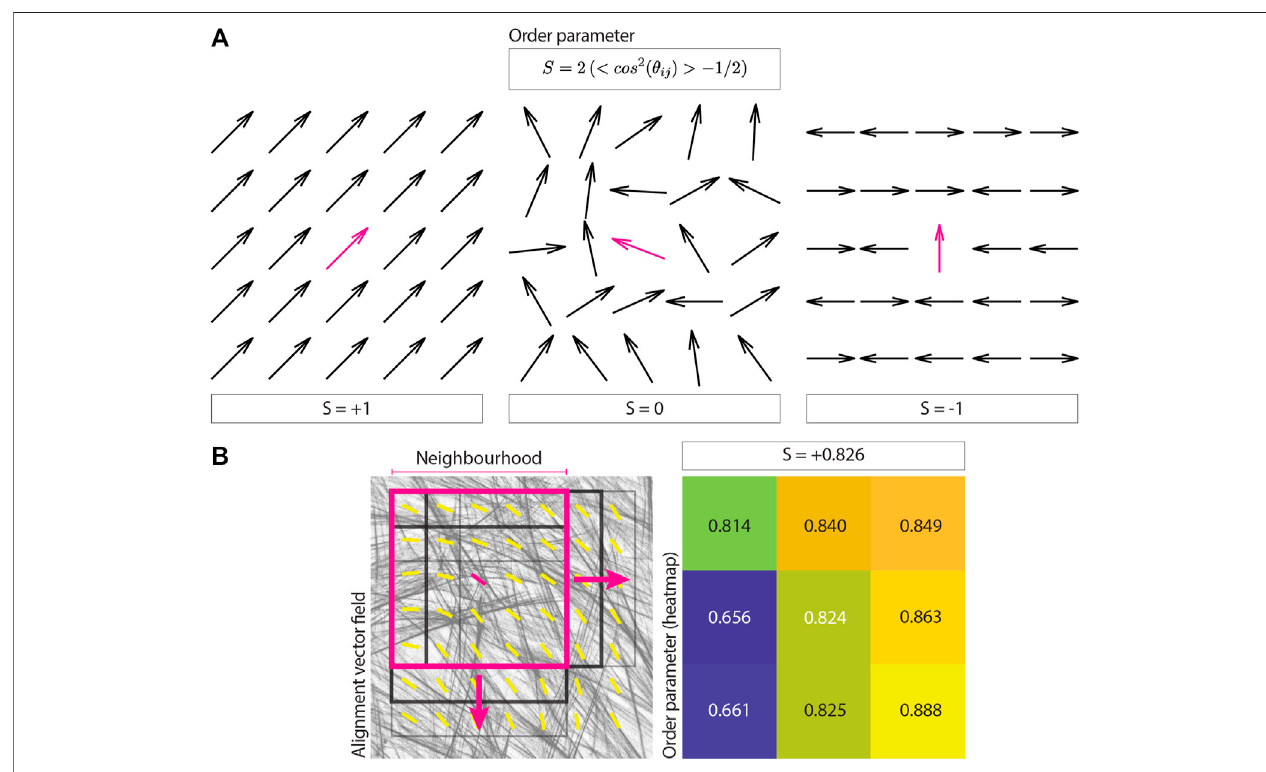
FIGURE 2 | Calculating an image order parameter. (A) The equation for the order parameter used to assign an alignment score for each neighborhood is shown, together with examples. The order parameter takes a value of 1 for complete alignment, 0 for random alignment, and − 1 for orthogonal alignment. (B) A square representinganeighborhoodof5 x vectors(magenta,neighborhoodradiusof2 x vectorsaroundthecentralreference)isoverlaidonanactinimageanditscorresponding alignment vector fi eld. The black squares represent subsequent instances of such neighborhood, as the vector fi eld is scanned during the analysis to obtain local alignment scores. The resulting order parameters for each neighborhood are reported in the heatmap, together with their median value, representing the output of the